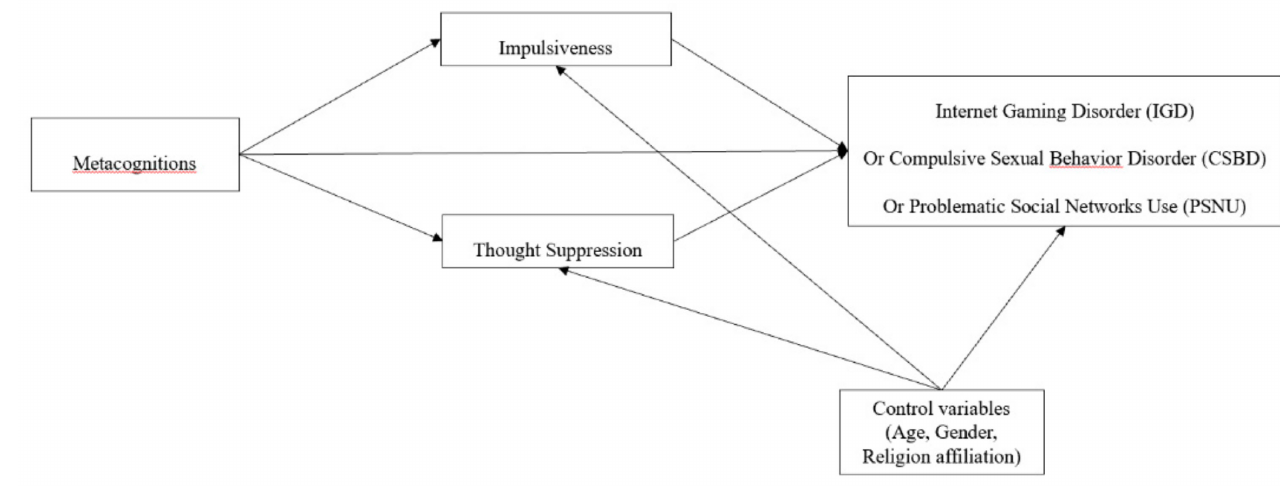
Figure 1. Hypothesized theoretical